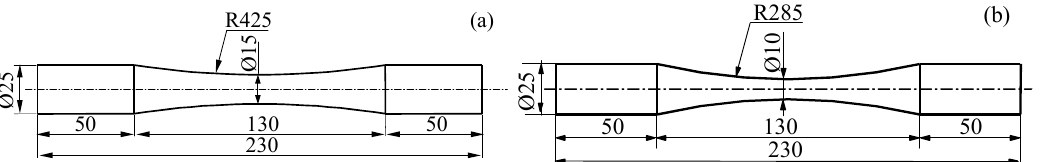
Figure 3: Specimens’ geometry adopted for fatigue tests having a) load ratio R=-1 e R=0.1 and b) R=0.5. To evaluate the thermoelastic material constant K m , Eq. (4), load controlled ramps were executed at different load rates by means of a servo-hydraulic Schenck Hydropuls PSA 100 machine equipped with a 100 kN load cell and a Trio Sistemi RT3 digital